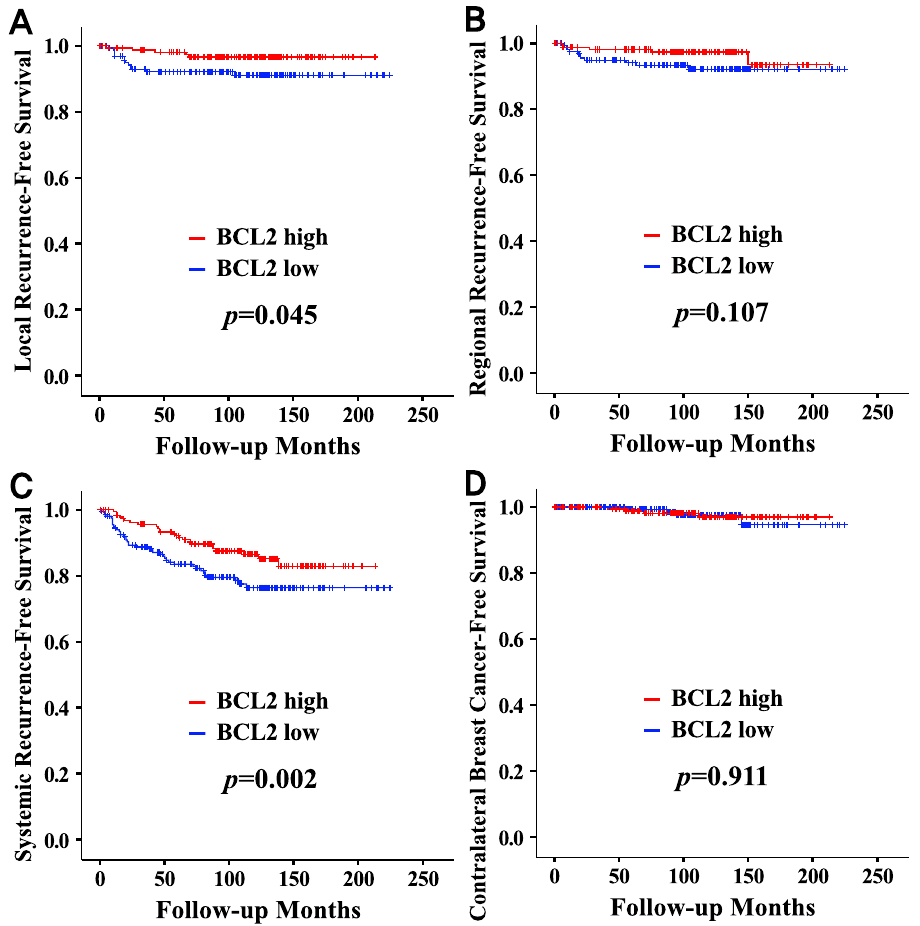
recurrence-free survival ( D